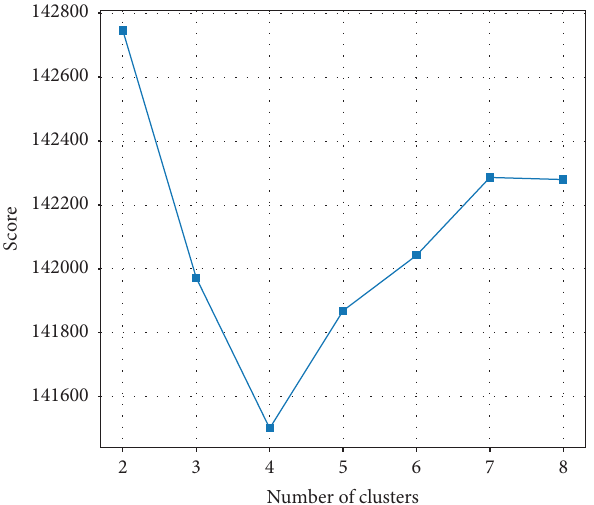
Figure 3: BIC scores for GMM results.